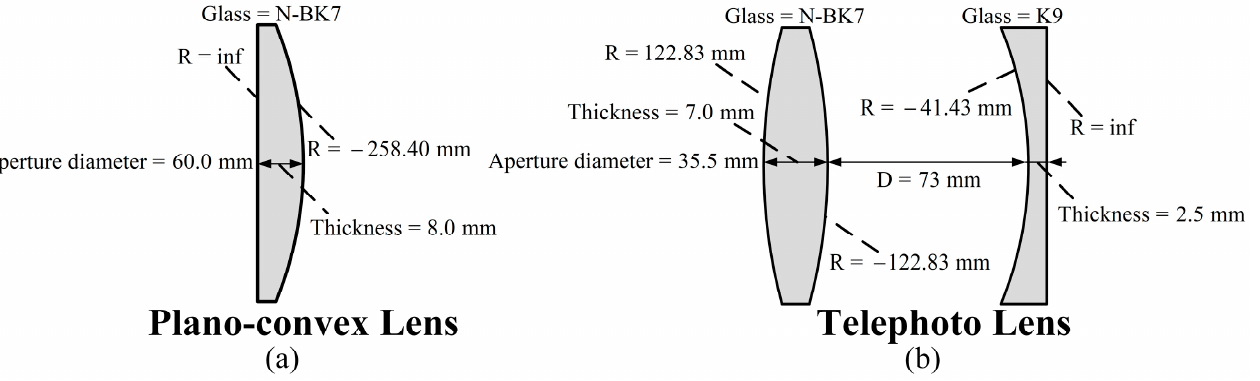
Figure 2. The parameters of imaging lenses in the simulation: ( a ) the parameters of the plano-convex lens; ( b ) the parameters of the telephoto lens.